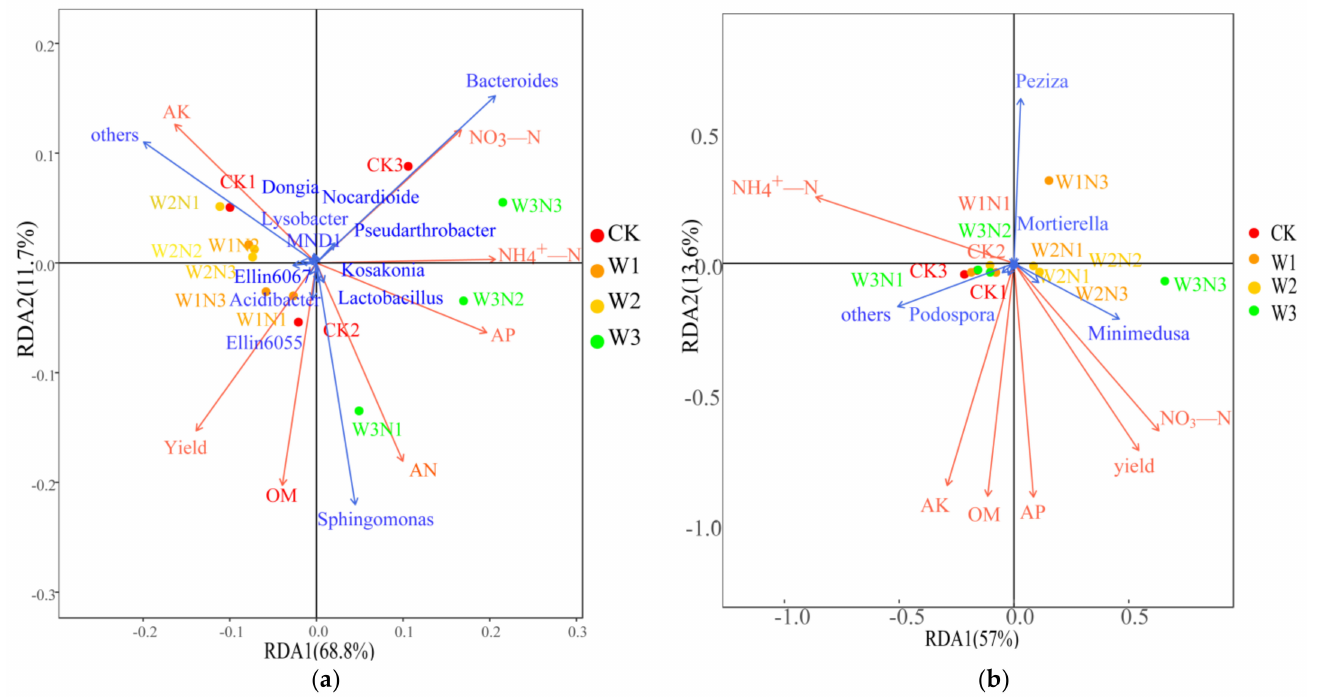
Figure 4. Analysis of the relationship between soil environmental factors and key microorganisms. Note: The red arrows represent different environmental factors, and the blue arrows represent the various microbial genera. The angle between species and environmental factors represents the posi- tive and negative correlation between them (acute angle: positive correlation; obtuse angle: negative correlation; right angle: no correlation). ( a ): the analysis of the relationship between soil environmen- tal factors and soil bacteria; ( b ): the analysis of the relationship between soil environmental factors and soil